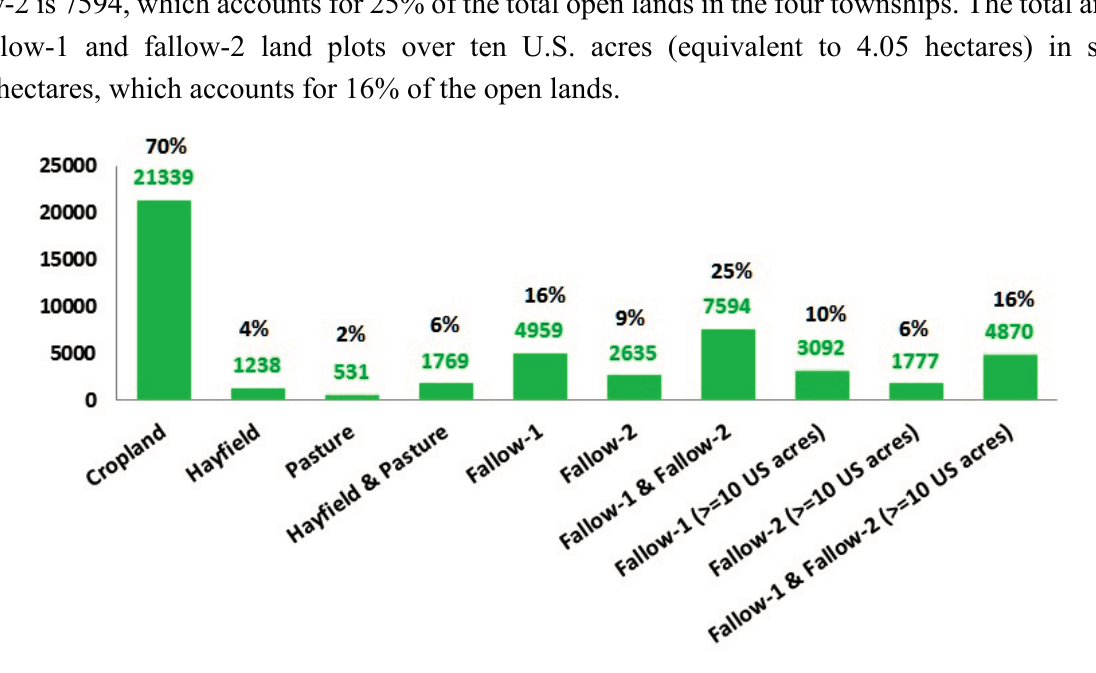
Figure 7. Land area (hectares) and percent coverage within all the four townships combined. Percentages are based on total open land (“open land” refers to all land uses except for forests, water bodies, wetlands, wastelands, and developed lands). The last three categories are for plots that are equal to or greater than 10 U.S. acres (or 4.05